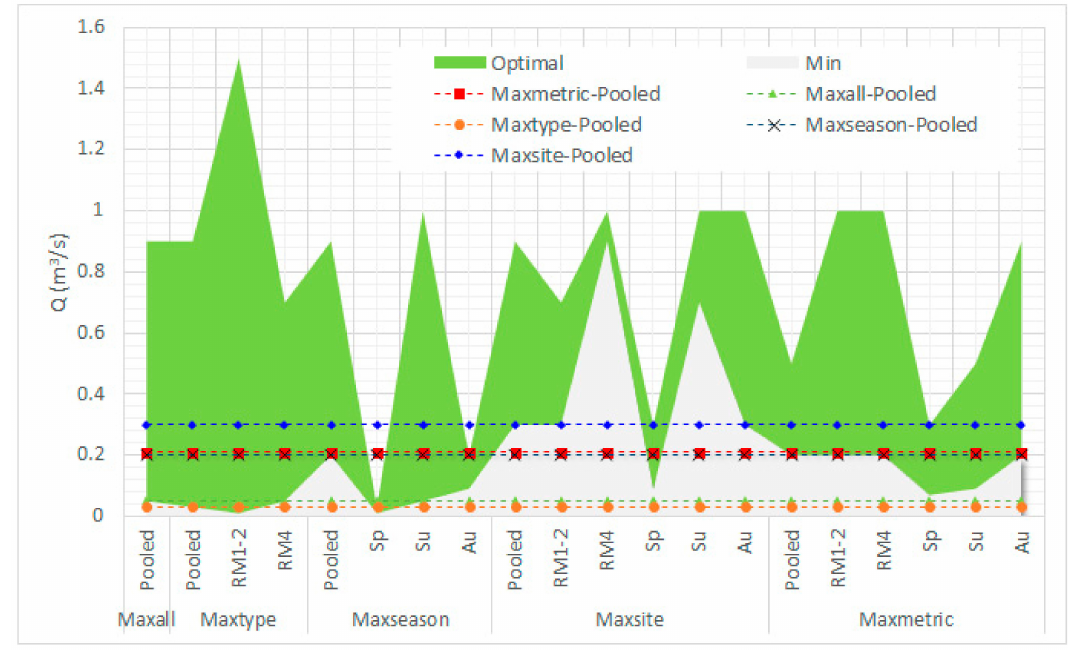
Figure 11. Overall comparison on the selection of the minimum acceptable and optimal environmental flow in the Oinoi Stream between the various habitat-suitability calculation-normalization options including seasonal and typological variation (Sp: Spring; Su: Summer; Au: Autumn). Predictions within the green area are considered acceptable (lying between the minimum and optimal environmental